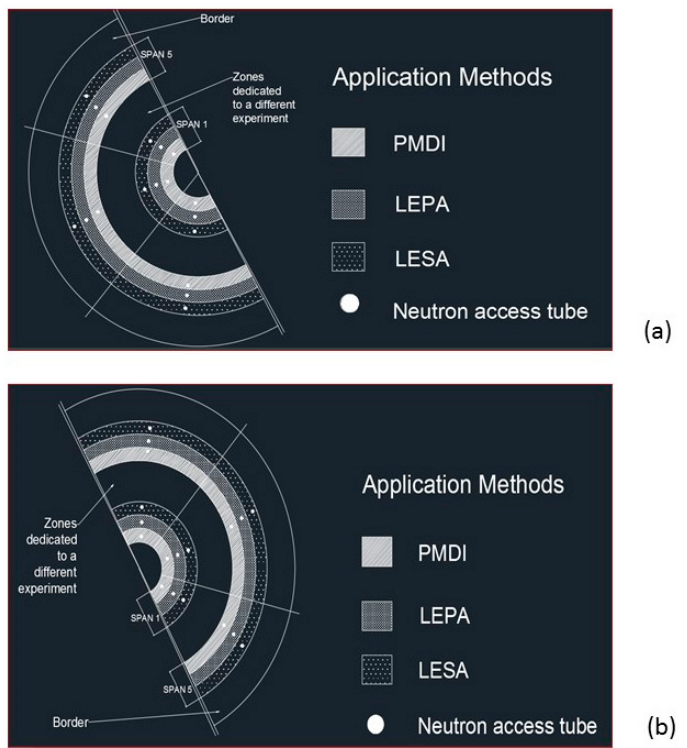
Figure 2. Plot plan showing randomized block design layout to compare MDI with LEPA and LESA in spans 1 and 5: ( a ) 2015 growing season; and ( b ) 2016 growing season in Bushland, TX, USA. Design details of the MDI system must ensure that movement of driplines towards the crop rows crop. The MDI driplines were a trademarked product, Dragonline™ (Ulysses, KS, USA) (Disclaimer: